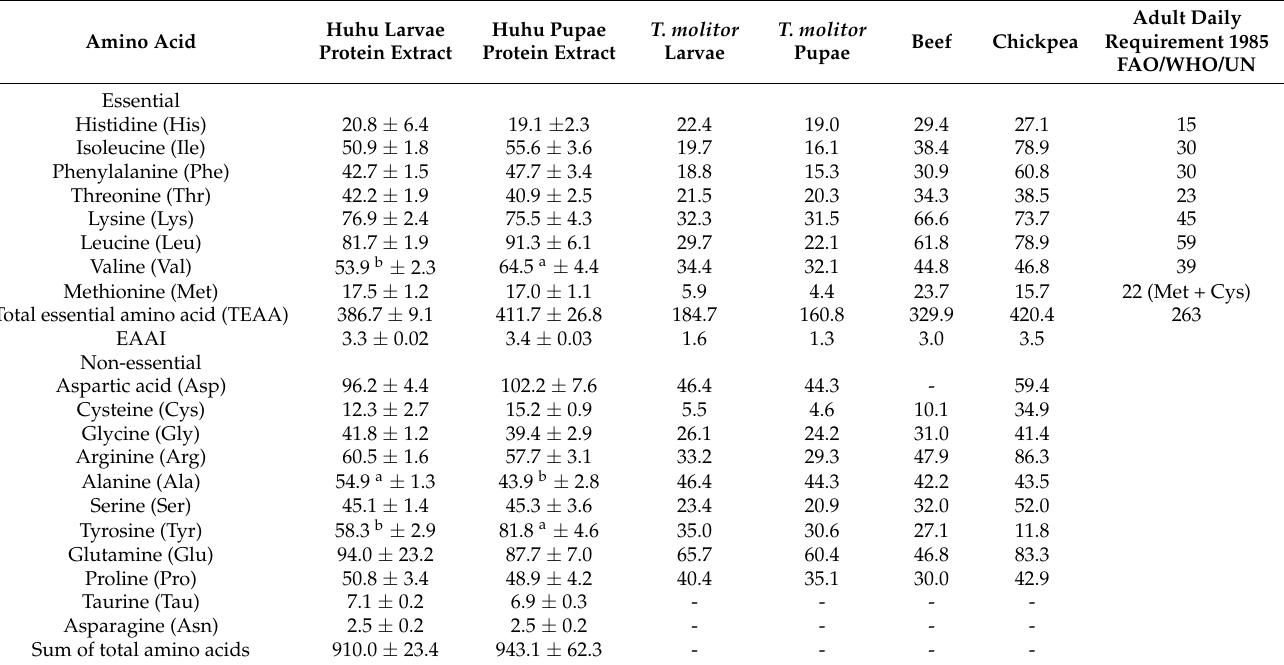
Table 1. Amino acid composition (mg/g protein) of Huhu grub protein extracts and Tenebrio molitor larvae and pupae protein extracts in comparison to beef and chickpea protein extracts, with the daily essential amino acid requirements for an adult